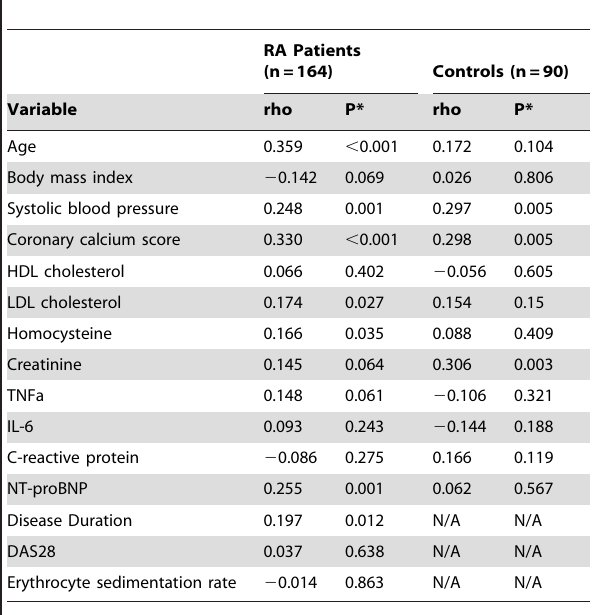
Table 2. Correlation between hs-cTn-I and clinical variables in patients with RA and controls.